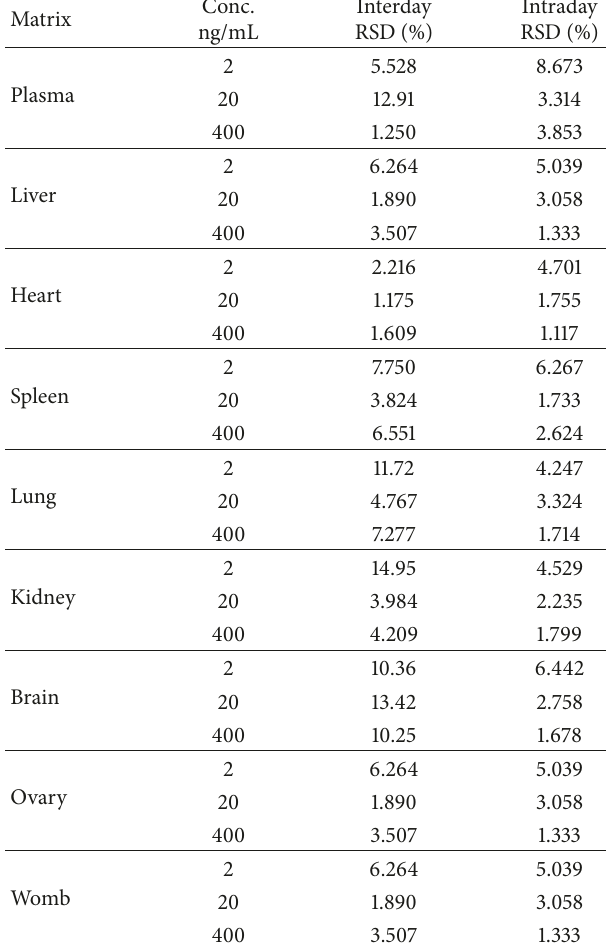
Table 2: Intra- and interday accuracy and precision for the deter- mination of epimedin B in plasma and tissue samples ( 𝑛 = 18 , 6 replicates per day for 3 days).